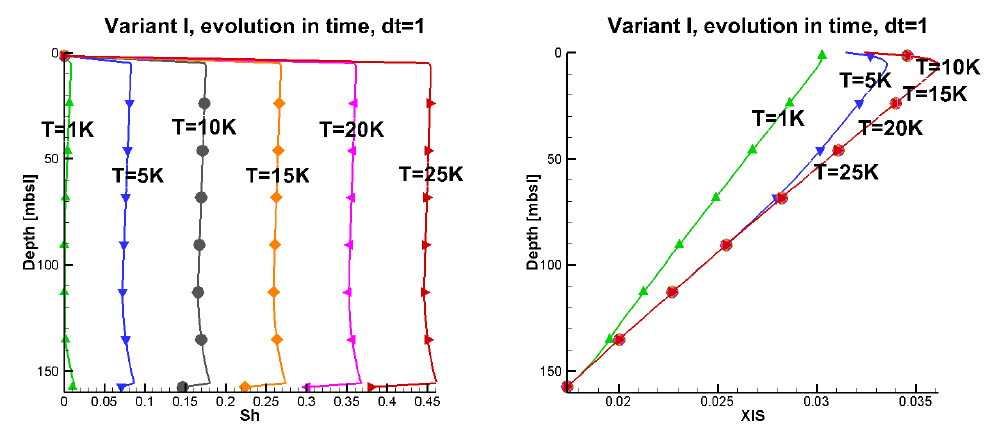
Figure 2. Evolution of hydrate saturation and of salinity for the base case. ( left ) Plot of S h , ( right ) Plot of χ lS . Variable χ lM equals χ max at these times and is not lM